Question: Express in one sentence what the figure is showing.
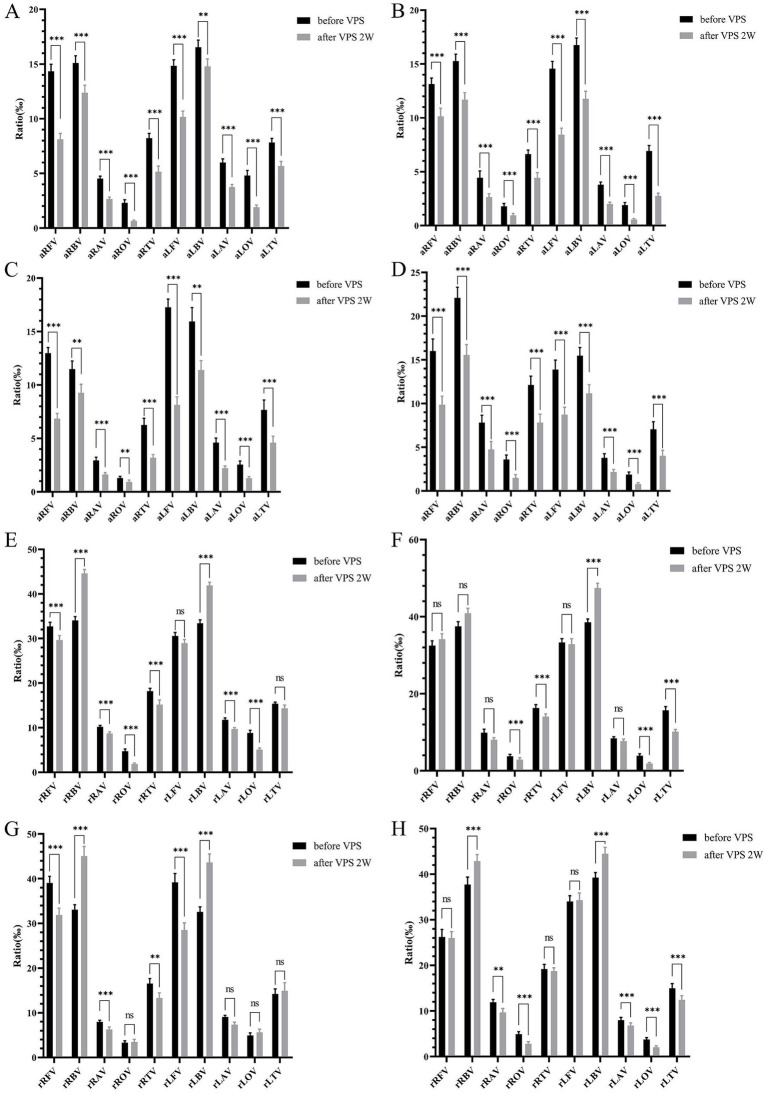
Answer: Comparison of ventricular volume in the lateral ventricle subregions before and after VPS in HANPH. It shows differences in the absolute ventricular volume of the lateral ventricle subregions before and after VPS in HANPH (non-DC, RSC) (A) , HANPH (non-DC, LSC) (B) , HANPH (DC, RSC) (C) , and HANPH (DC, LSC) (D) . Additionally, differences in the relative ventricular volume of these subregions before and after VPS are observed in HANPH (non-DC, RSC) (E) , HANPH (non-DC, LSC) (F) , HANPH (DC, RSC) (G) , and HANPH (DC, LSC) (H) . ns: p ≥ 0.05, * p < 0.05, ** p < 0.01 and *** p < 0.001.